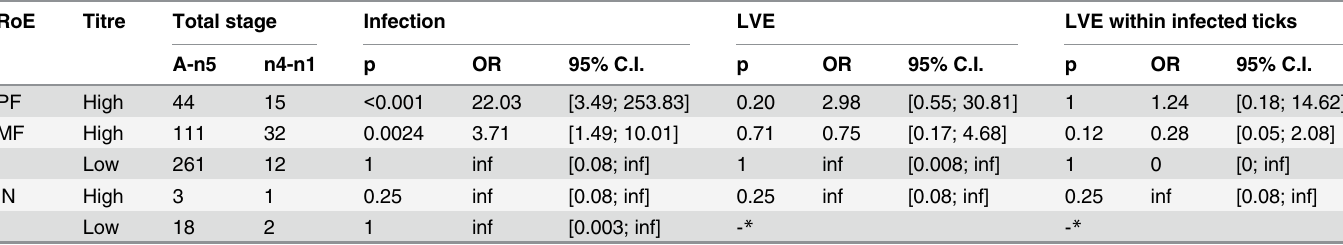
There was also no effect of gender on infection, LVE or LVE within the infected ticks (see S2 Table). Inoculated ticks. Sixty seven ticks were subjected to inoculation of virus, but only 24 were available for analysis 39 days post inoculation, which represents an overall mortality rate of 64.2%. For ticks inoculated with high titres the mortality rate was 88% and for ticks inoculated with low titres, 39.4%. In this way, only 4 ticks (16.7% of 24) inoculated with high titres of viruses H or T, and 20 ticks (83,3% of 24) inoculated with low titres of viruses H or T were available for analysis 39 days post inoculation (Table 5).